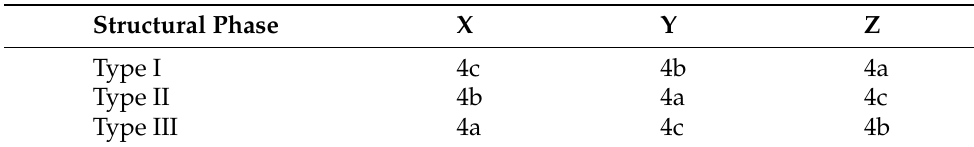
Table 1. The Wyckoff positions of the three atoms, X, Y, and Z: 4a = (0, 0, 0) a, 4b = (0.5, 0.5, 0.5) a and